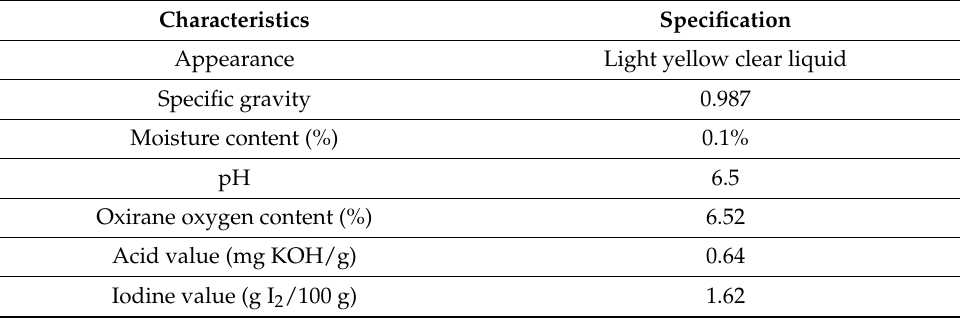
Table 1. Specifications of Epoxidized Soyabean Oil(ESBO).